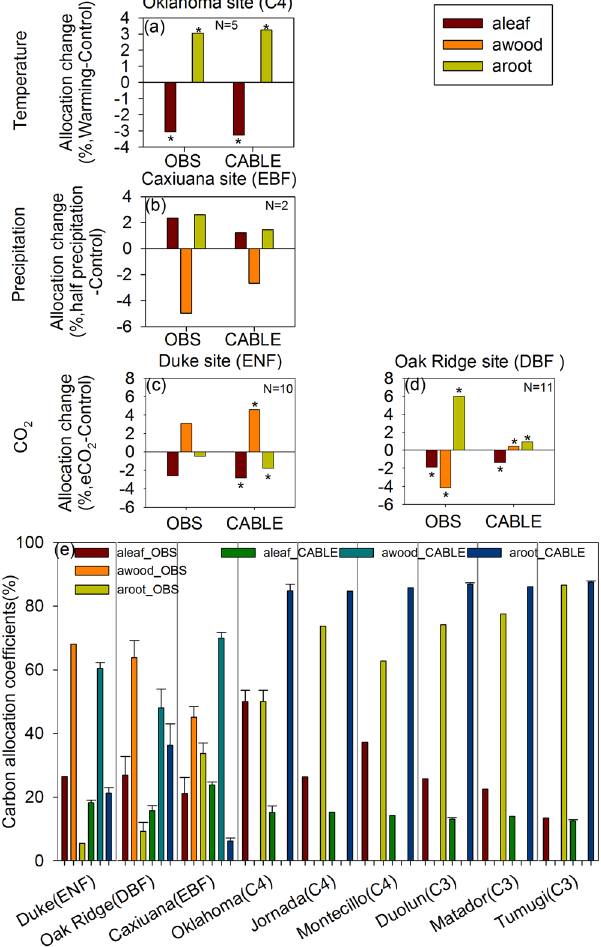
Figure 1. Comparison of carbon allocation coefficients to leaves (aleaf), woody tissues (awood), and roots (aroot) between observations (OBS) and CABLE model with the resource limiation allocation scheme at warming ( a ), precipitation reduction ( b ) and elevated atmospheric CO 2 (eCO 2 , c , d ) sites and and natural sites ( e ). ENF: evergreen needleleaf forest; EBF: evergreen broadleaf forest; DBF: deciduous broadleaf forest; C3: C3 grass; C4: C4 grass. * Significant change ( p <